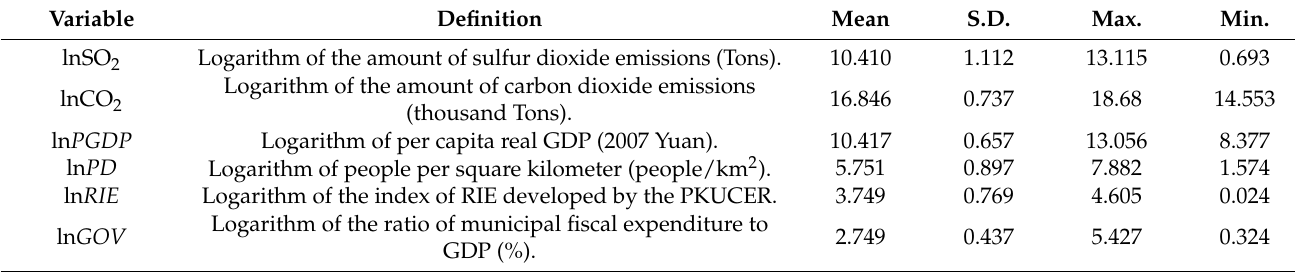
Table 2. Definitions and descriptive statistics for the